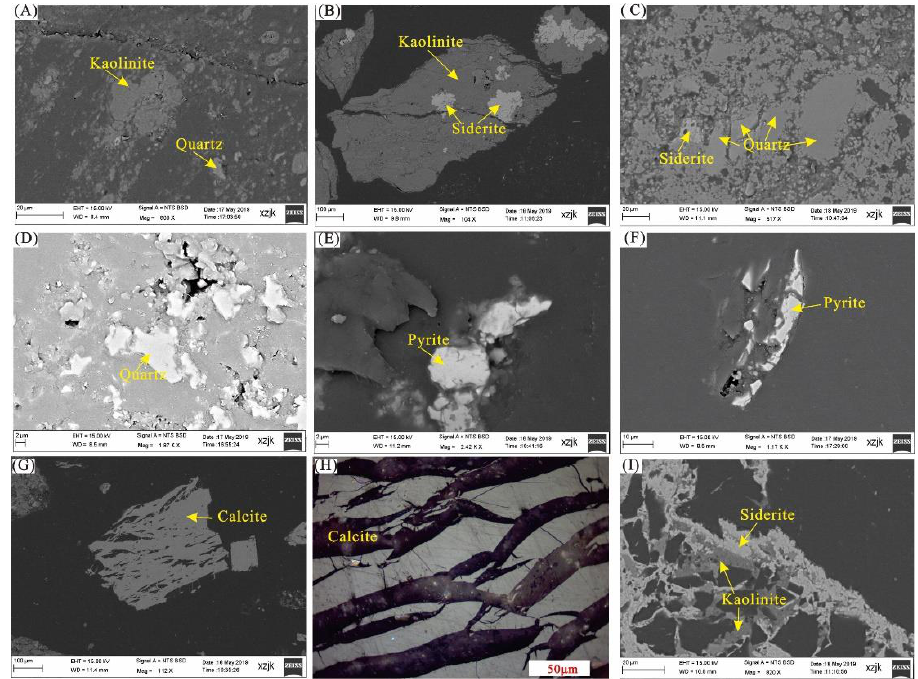
Figure 10. Minerals in samples from Junde mine (SEM, SE mode). ( A ) Kaolinite and quartz in sample JD-26-05; ( B ) Kaolinite and siderite in sample JD-26-06; ( C ) Siderite and quartz in sample JD-26-04; ( D ) Quartz in sample JD-26-05; ( E ) Pyrite in sample JD-26-04; ( F ) Pyrite in sample JD-26-05; ( G ) Calcite in sample JD-26-04; ( H ) Fracture-filling calcite in sample JD-26-05, Reflected light, oil immersion; ( I ) Siderite and kaolinite in sample